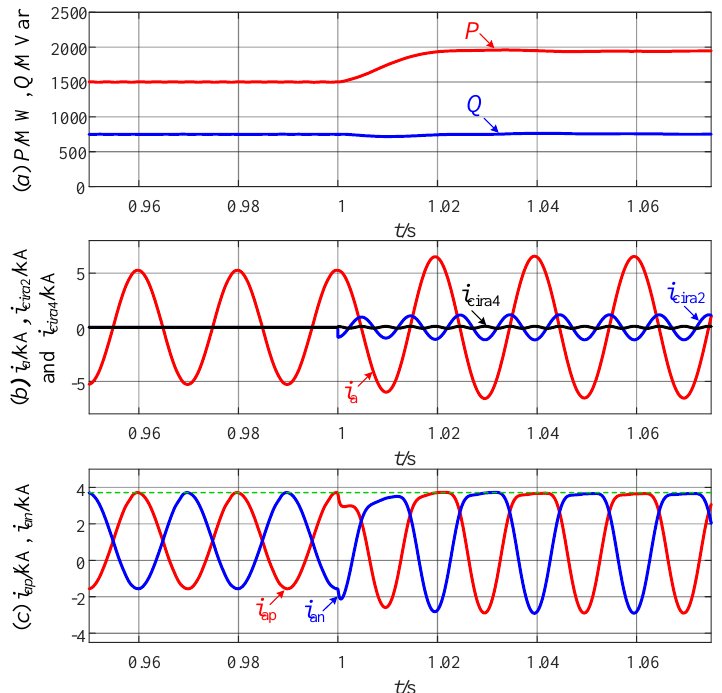
Figure 11. Simulation waveforms of the overload performance of the MMC.